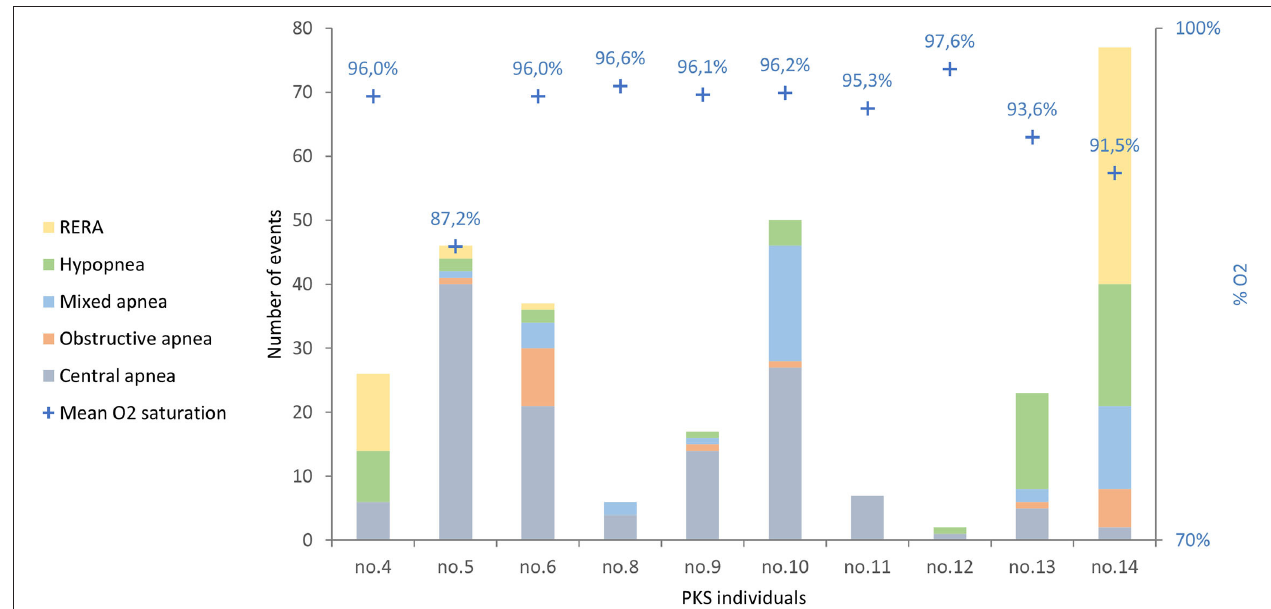
FIGURE 1 | The respiratory events in the 10 PKS subjects evaluated are shown, divided by type of respiratory event. RERA, respiratory effort-related arousal.